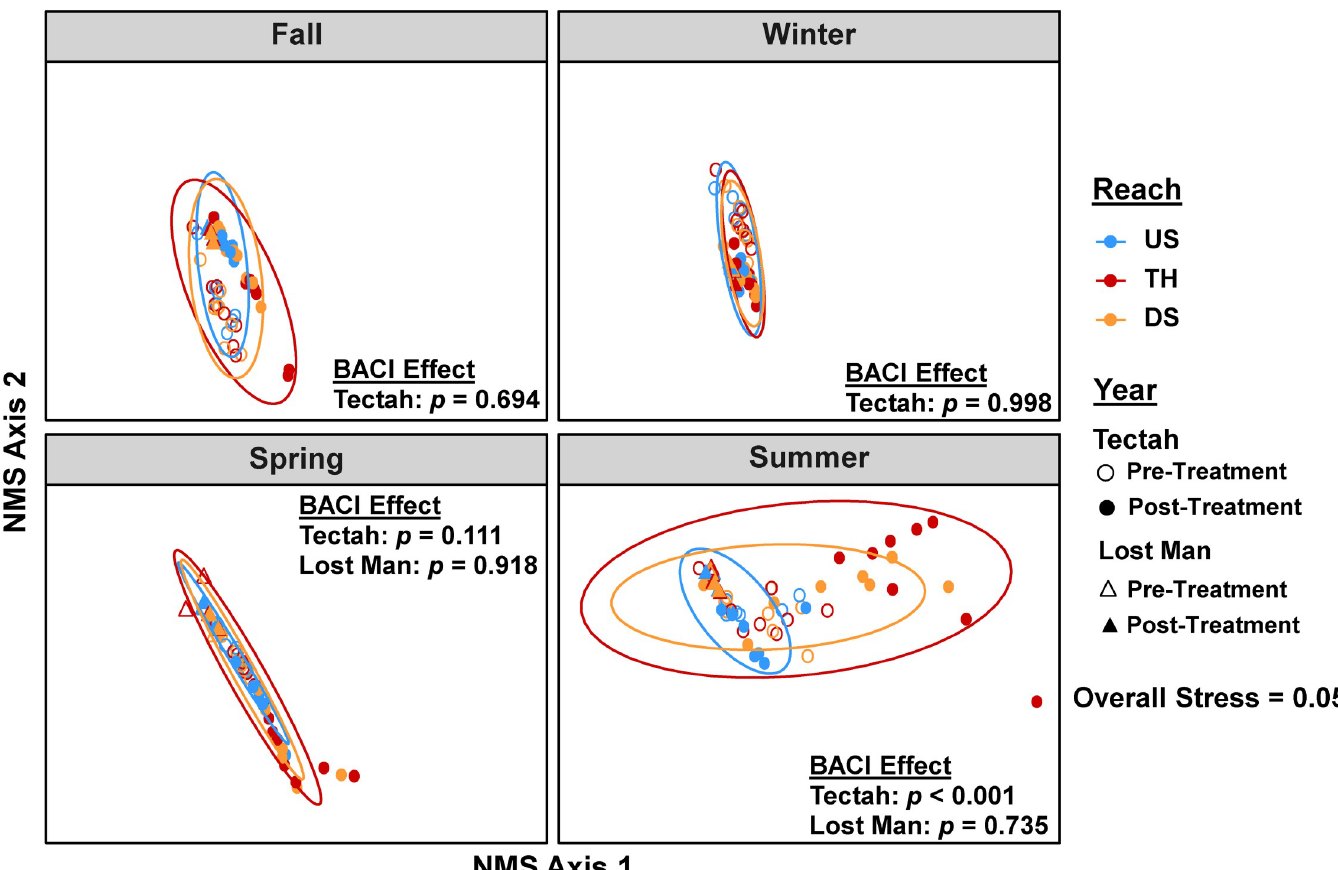
Fig 5. NMS ordinations of stream thermal regimes. Non-metric multidimensional scaling ordinations of the structure of stream thermal regimes in response to riparian thinning in northern California second-growth redwood forests. Each point represents the structure of a stream thermal regime at a site with colors indicating reach type and shapes indicating pre-treatment or post-treatment years for each watershed. The proximity of points provides an indication of how similar thermal regimes are between reaches (upstream reference, thinned, downstream), years (pre-treatment, post-treatment), and seasons (fall, winter, spring, summer) for the Tectah and Lost Man watersheds. Ellipses indicate 95% confidence intervals around the grouping variable of reach. PerMANOVA tests indicated whether the structure of stream thermal regimes differed significantly by the BACI effect of Reach � Year ( α = 0.05).